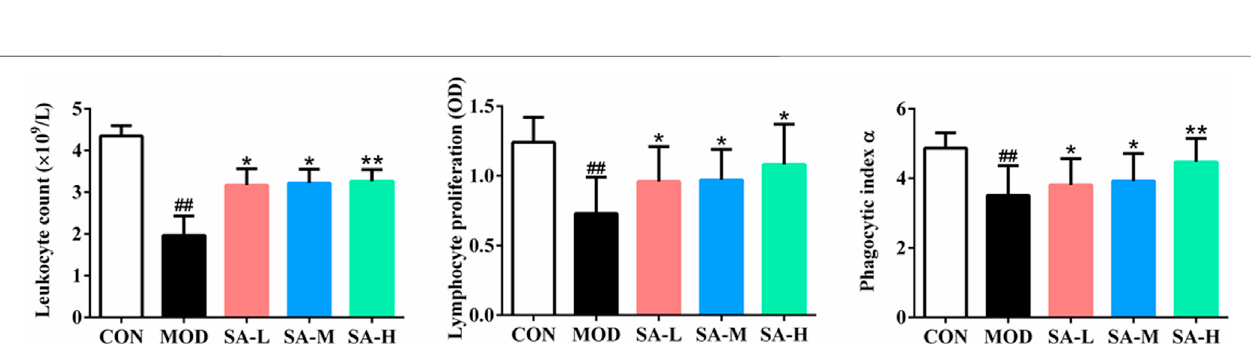
FIGURE 6 | Effects of SA on the leukocyte number, lymphocyte proliferation and macrophage phagocytosis of mice. Notes: Groups: CON, control group; MOD, model group; SA-L, Schisandrol Alow-dosegroup; SA-M, Schisandrol Amedium-dose group; SA-H, Schisandrol A high-dose group. All the values were expressed as mean ± standard deviation ( n (cid:1) 12). ##: p < 0.01, vs . CON; *: p < 0.05, vs . MOD; **: p < 0.01, vs .